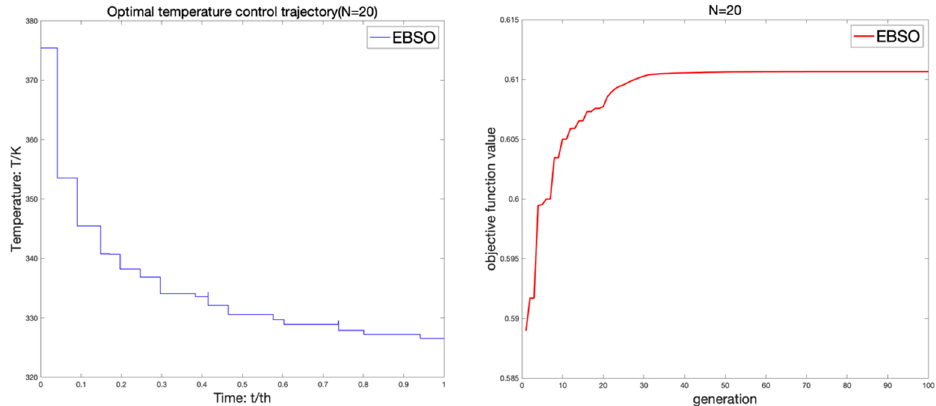
Figure 24. Optimal temperature control trajectory and iteration curve ( N = 20).